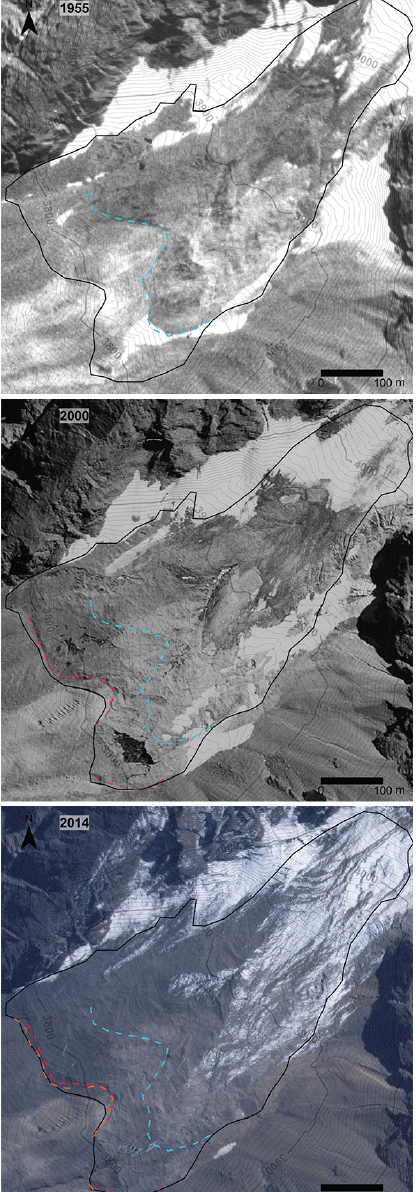
Figure 7. Sequence of orthophotos obtained for Presenteseracae. The base of the landform front that could be reliably identified is indicated in colour (blue, magenta, and orange line in 1955, 2000, and 2014, respectively). Note how the rock glacier morphology de- veloped since 2000. In the southern part of the landform, it is never- theless less well defined and more unstable; it is conspicuously cut by a central furrow and exhibits a few areas of bare ice over which debris slumps may occur. In the northern part of the landform, the rock glacier morphology is more developed; there is neither remain- ing bare ice area nor evidence of debris cover instability and sliding.